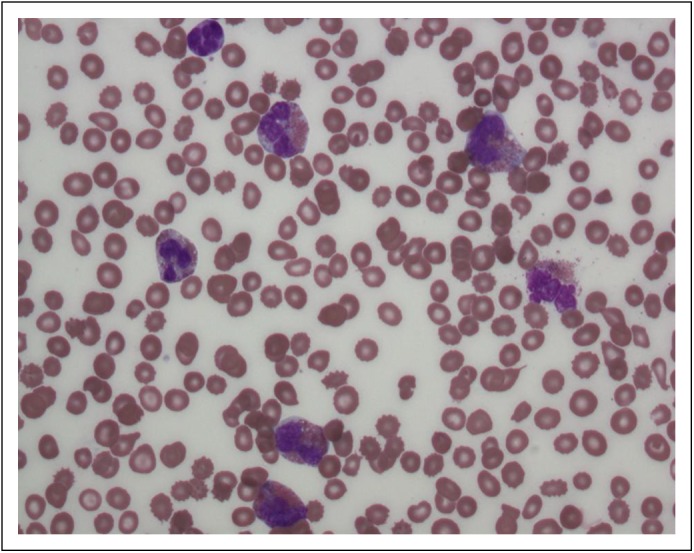
– Peripheral blood smear showing morphologically abnormal
eosinophils. Note the large, bright-orange granules.